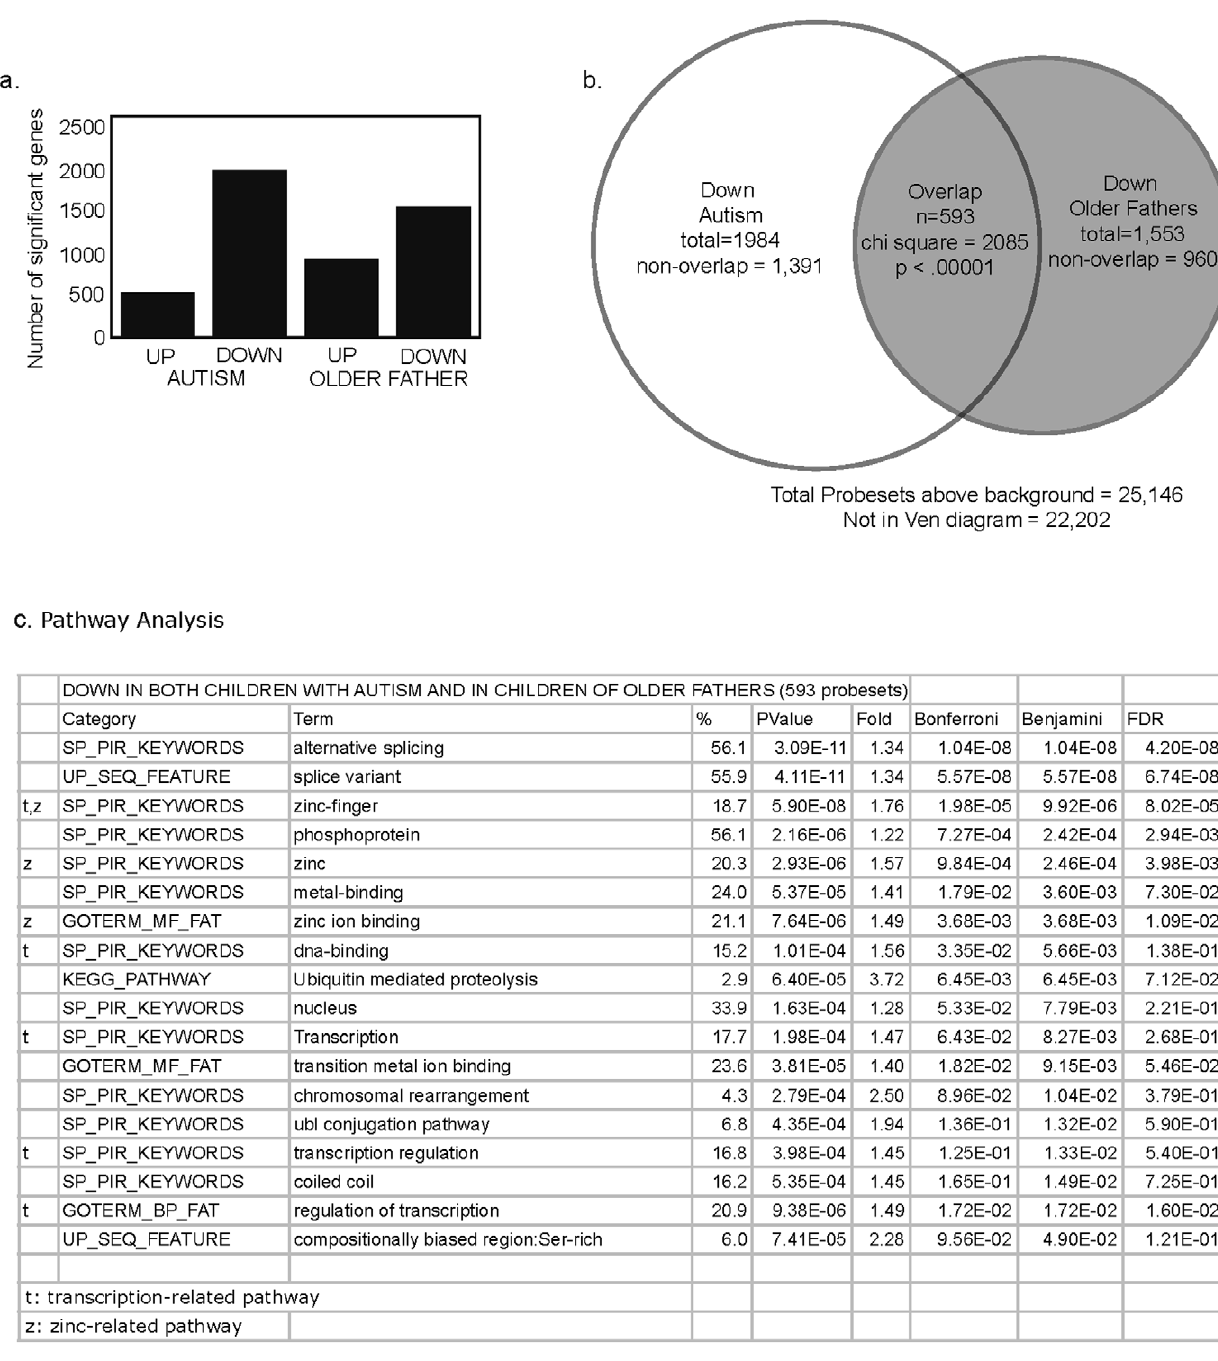
Figure 4. Down-regulated genes are enriched for biological pathways related to transcription and zinc. Traditional gene expression analyses were performed. Microarrays were processed and summarized using RMA. Post-summarization gene expression levels were quantile normalization because of the known group level differences at the level of the distribution. Probe sets were filtered for those that were called present in at least 50 of 146 samples. Figure 4a shows that there were more down-regulated than up-regulated genes in the blood of children with autism and children of older fathers when compared to children of younger fathers. 4b shows a very significant overlap (chi-squared =2,085, p , .00001) of down-regulated genes in children with autism and children of older fathers. Figure 4c demonstrates that overlapping down-regulated genes are enriched for biological pathways associated with transcription and zinc.